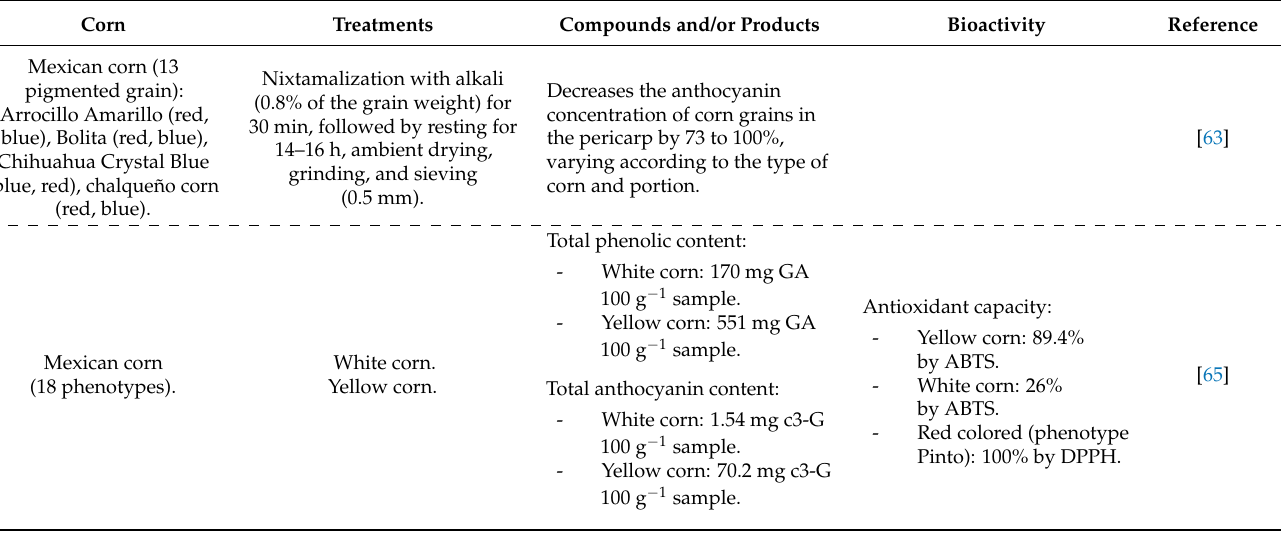
Table 4. Composition and/or bioactivity determined in maize of different types ( Zea mays L.) and applied treatments. Corn Treatments Compounds and/or Products Bioactivity